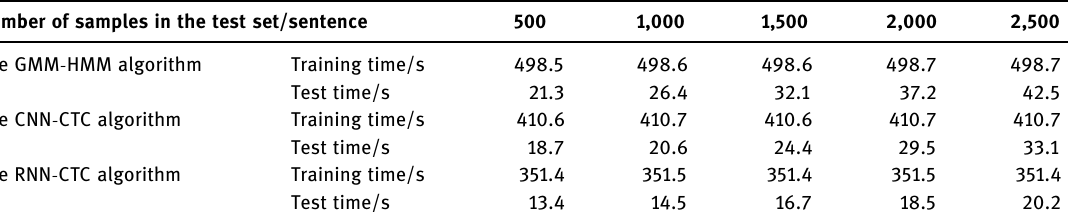
Table 2: Training and test time of the three speech recognition algorithms under di ff erent number of samples in the test set Number of samples in the test set/sentence